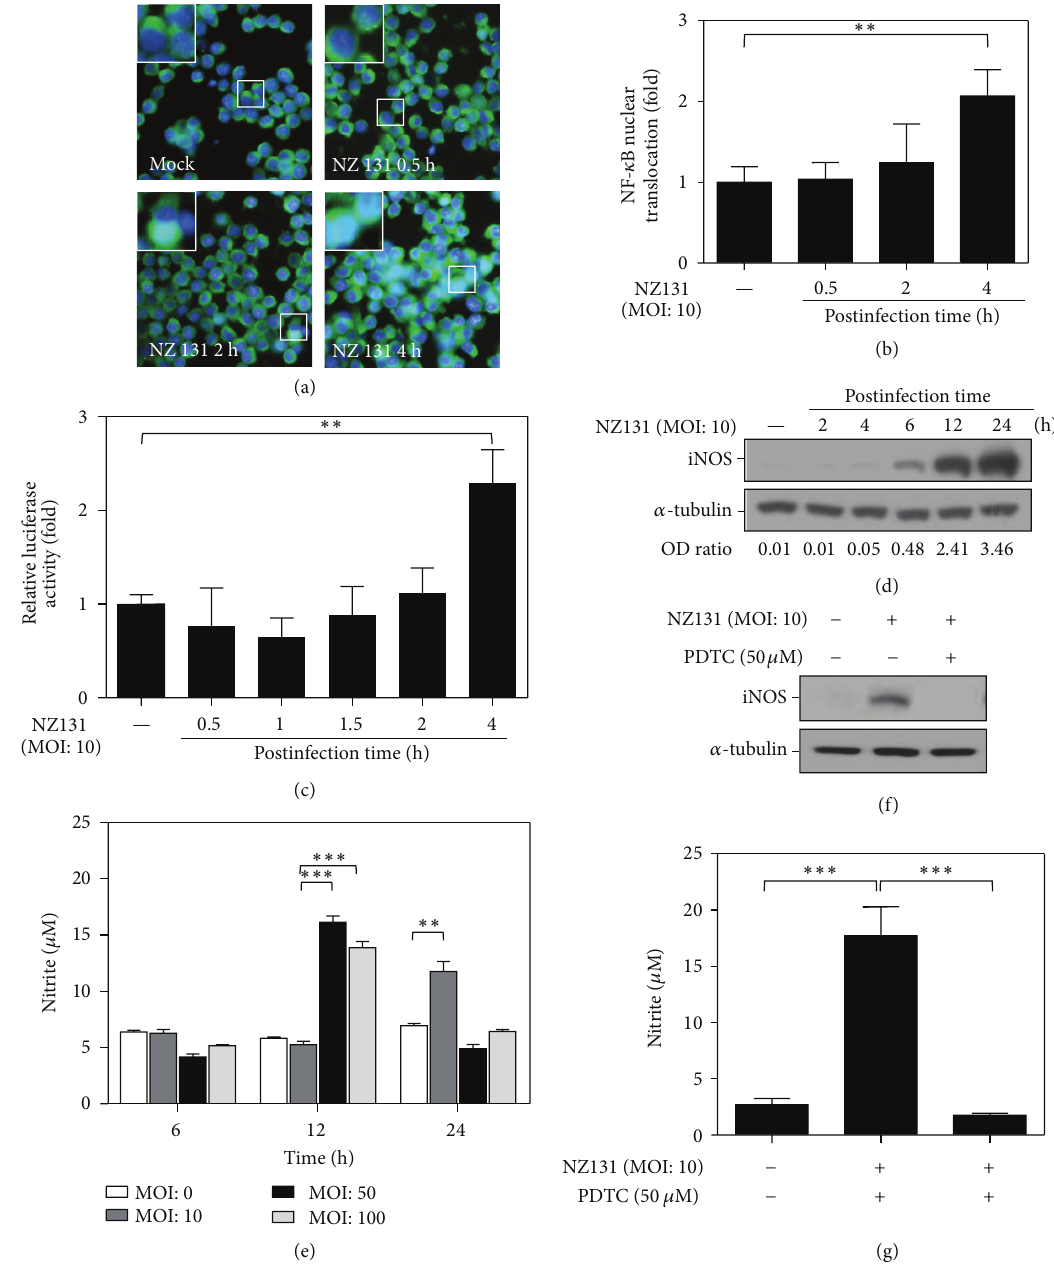
Figure 1: NZ131 infection induces the activation of NF- 𝜅 B and the increased expression of iNOS and NO in macrophages. (a) Using immunocytochemical staining for detection of NF- 𝜅 B p65 and DAPI for nuclear staining, the nuclear translocation of NF- 𝜅 B in RAW 264.7 cells (2 × 10 5 cells/well in 24-well culture plate) after NZ131 infection (MOI: 10) at different time points was detected. Representative fields of NF- 𝜅 B translocation in RAW 264.7 cells are shown. (b) The bar chart graph is the summary of (a) for the ratio of the change of NF- 𝜅 B nuclear translocation after NZ131 infection at different time points. (c) RAW 264.7 cells were cotransfected with NF- 𝜅 B promoter-driven luciferase reporter and Renilla luciferase-expressing plasmid for 24h. Then, RAW 264.7 cells were infected with NZ131 (MOI: 10) for 1h. Luciferase activity was used to determine the dynamic change of NF- 𝜅 B activity 0.5–4 h after infection and the relative luciferase activity is the activity whencomparedwithcellswithoutNZ131infection.(d)WesternblotanalysiswasusedtodeterminetheexpressionofiNOSinRAW264.7cells stimulated by NZ131 (MOI: 10) for the indicated time points. (e) Griess reagent was used to determine the NO production in RAW 264.7 cells after treatment with different MOI of NZ131 (MOI: 0, 10, 50, or 100) at various time periods (6, 12, and 24h after infection). (f) The expression of iNOS was determined by Western blot analysis with or without NF- 𝜅 B inhibitor, PDTC (50 𝜇 M), for 6 h after NZ131 infection (MOI: 10). (g) The NO production was measured by Griess reagent 24h after NZ131 infection (MOI: 10) with or without the concomitant treatment of PDTC. The data are means ± SD of the results obtained from three individual experiments. ∗∗ 𝑃 < 0.01 ; ∗∗∗ 𝑃 < 0.001 , comparisons between the indicated